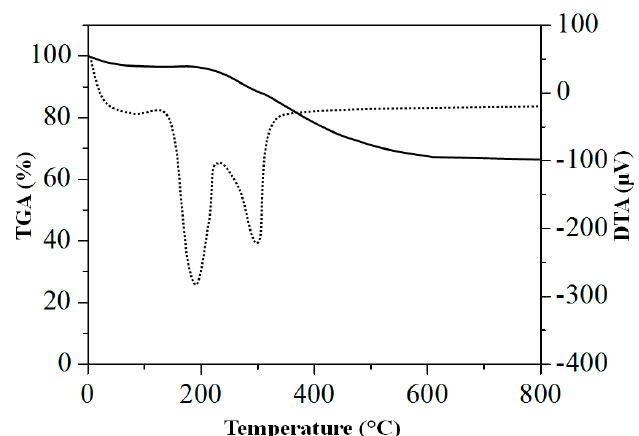
Figure 3. Thermogravimetric-differential thermal analysis (TGA-DTA) thermogram of the RS-HNP.